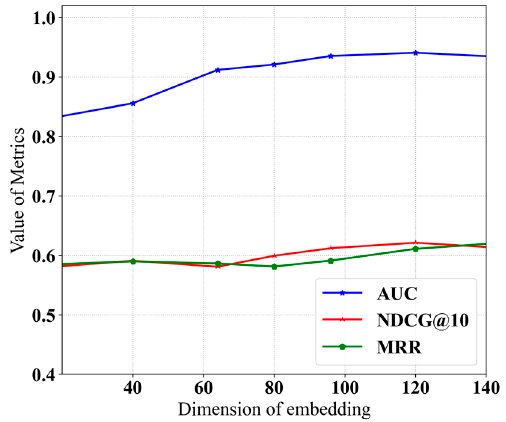
Figure 6. Impact of embedding dimension on model performance .